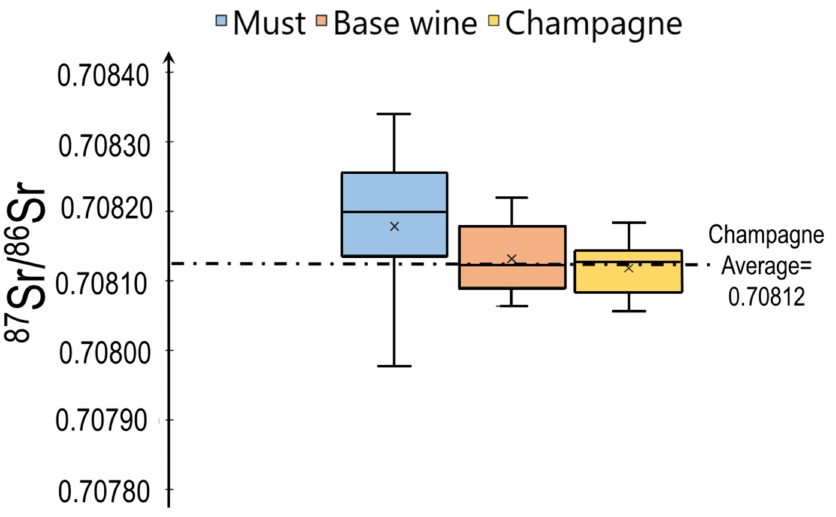
Figure 5. Evolution of the Sr isotopic ratio and the dispersion of the values (2 σ ) during the Cham- pagne making